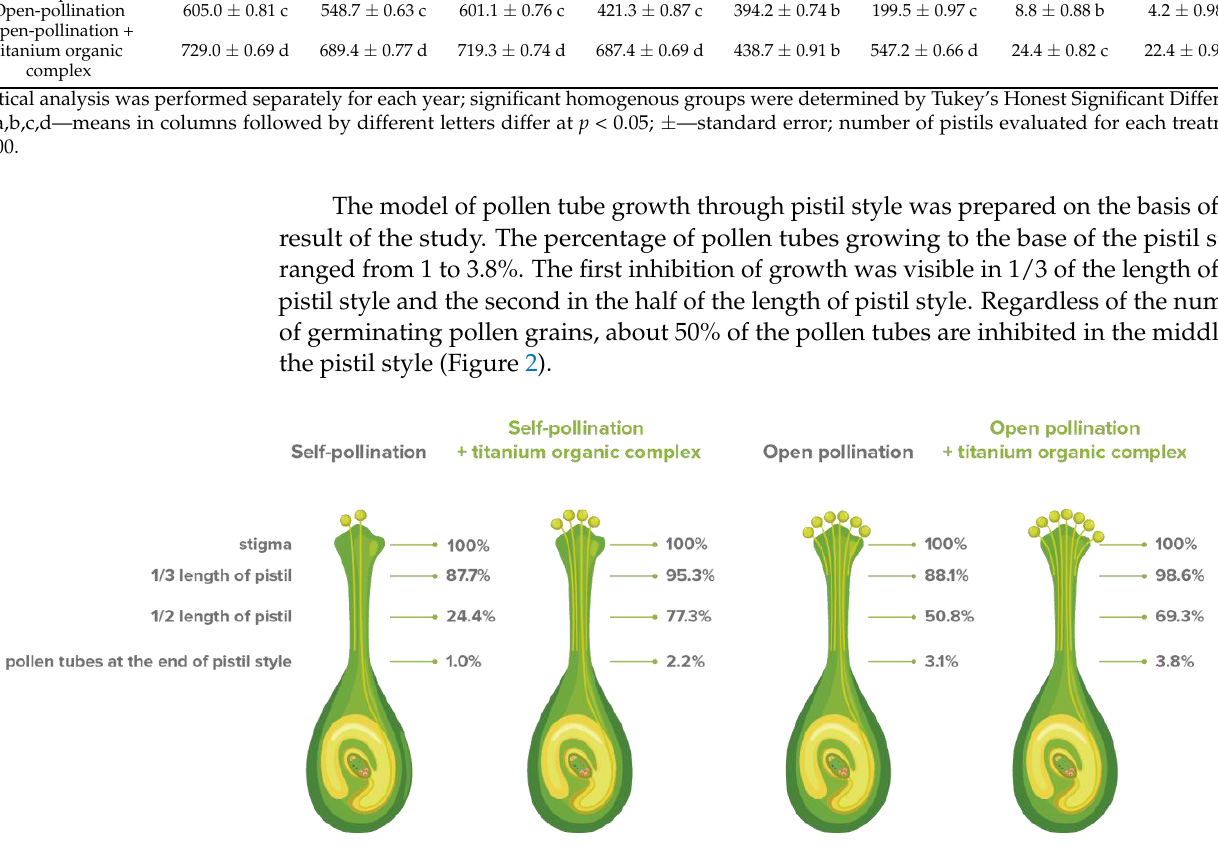
Table 1. The effect of titanium organic complex application on number of pollen grains germinating on pistil stigma and number of pollen tubes growing through pistil style (pieces).